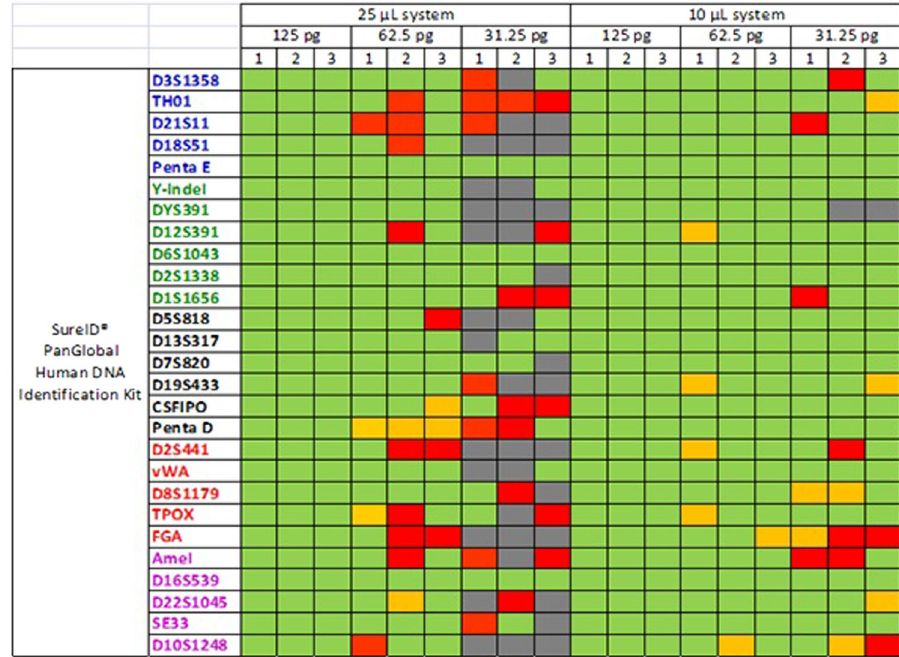
Figure 2. The sensitivity of the 25 µ L system and the 10 µ L system. 100 RFU was used as a threshold for detection. Green represents peak height ratio > 50% within the same loci. Yellow represents peak height ratio < 50% within the same loci. Red represents one of alleles drop-out within the same loci. Gray represents both of alleles drop-out within the same